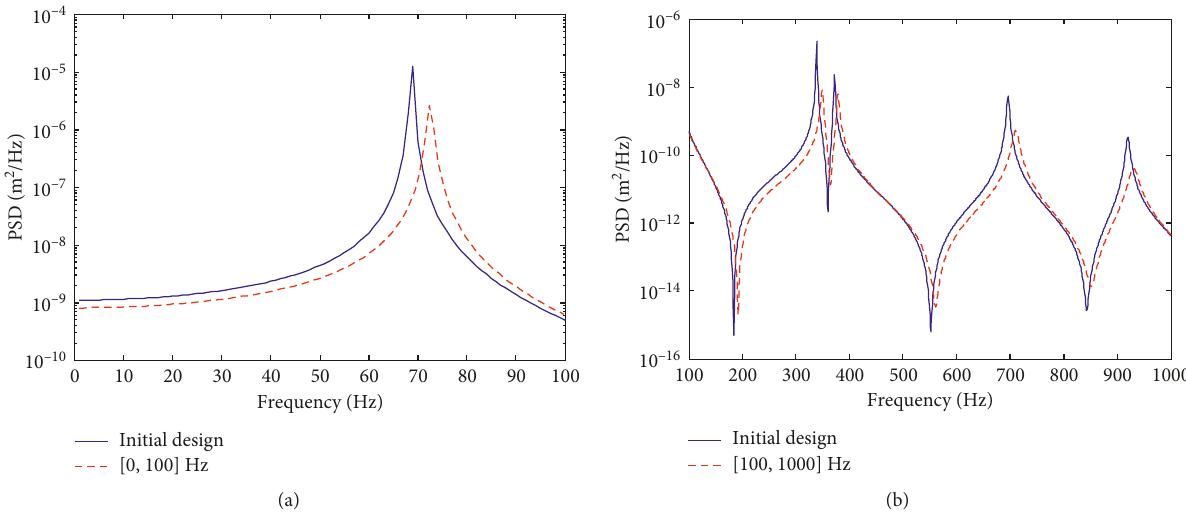
Figure 10: PSD curves of the initial and optimal design of CLD treatment. (a) f